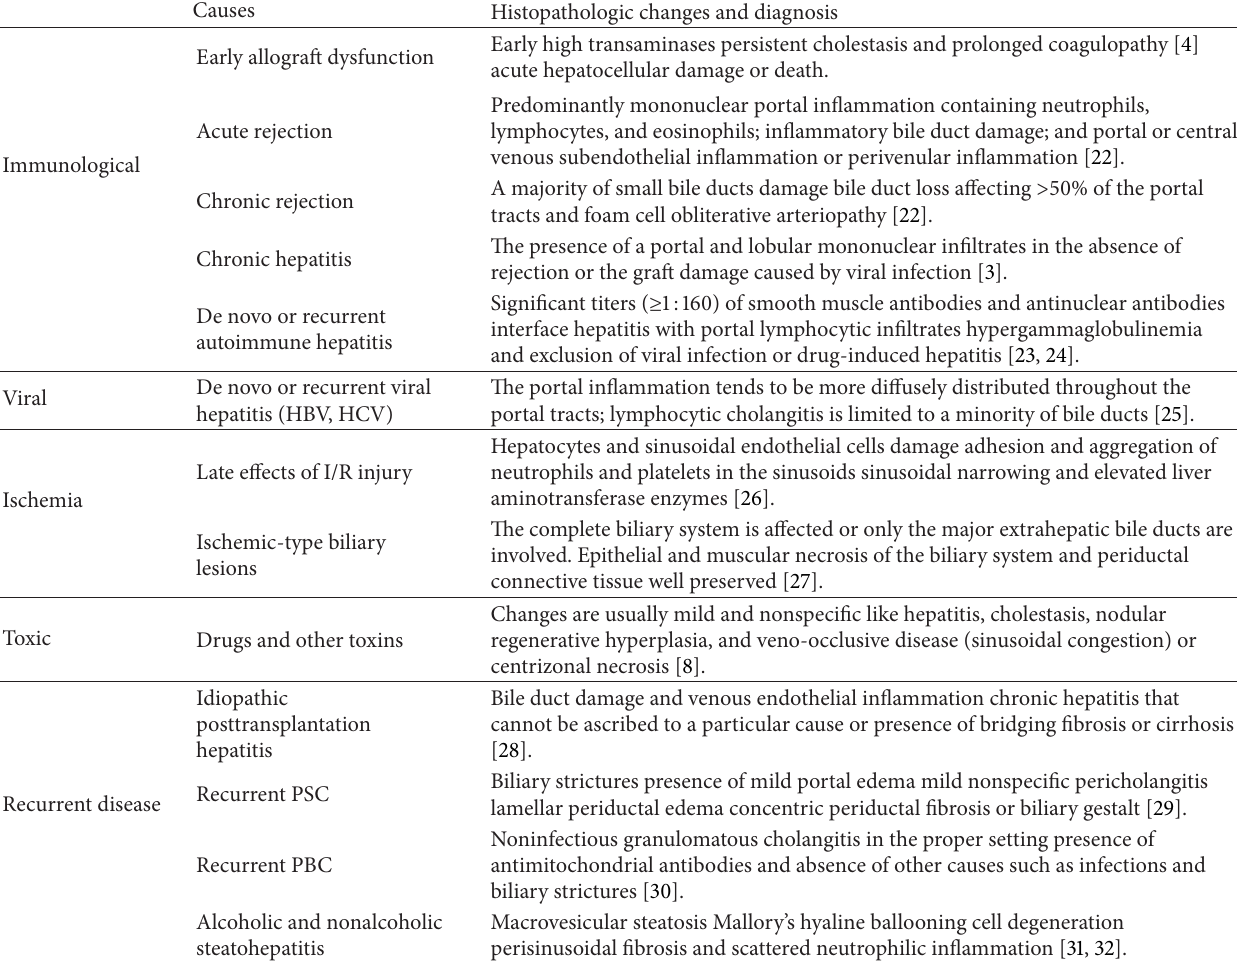
Table 1: Causes of chronic liver allograft